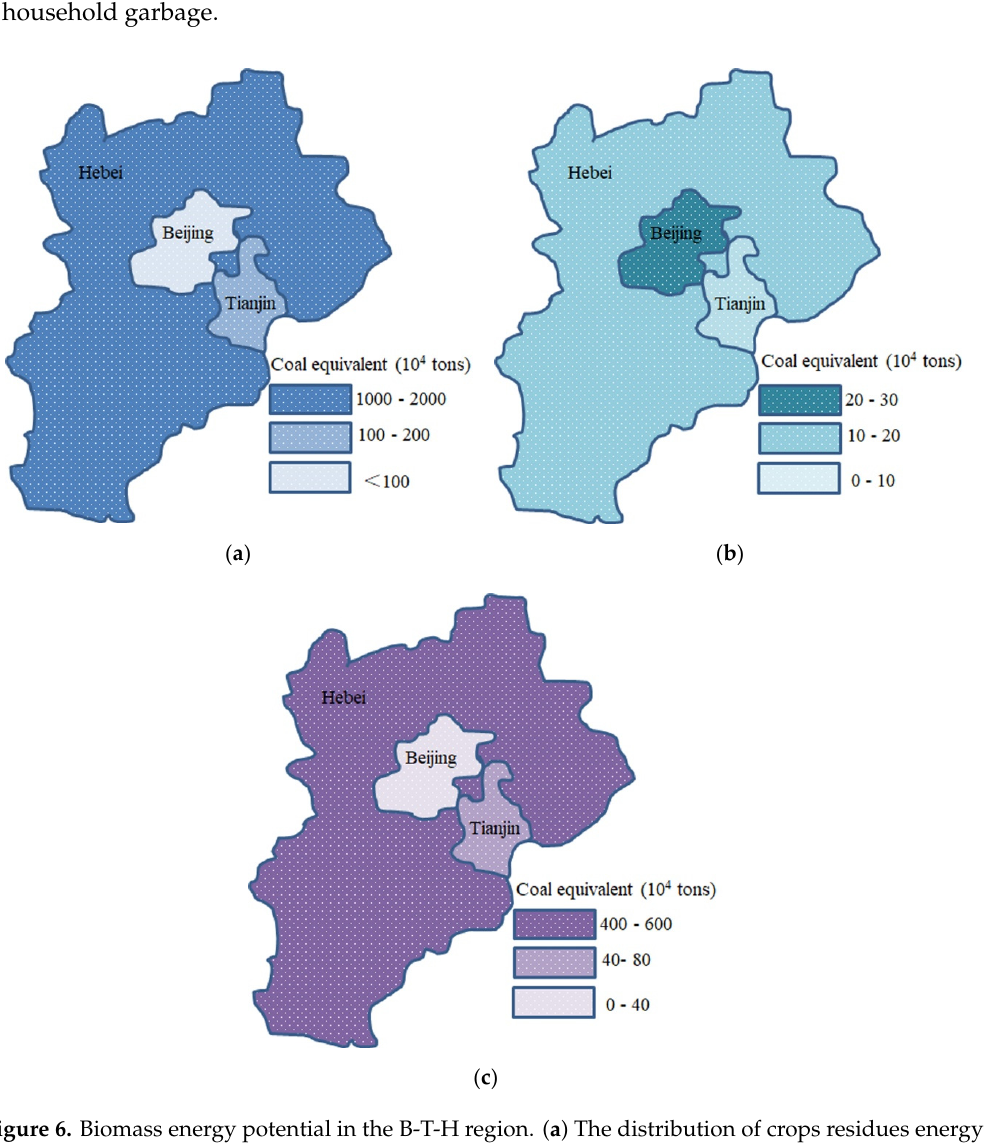
Figure 6. Biomass energy potential in the B-T-H region. ( a ) The distribution of crops residues energy potential in the B-T-H region. ( b ) The distribution of MSW energy potential in the B-T-H region. ( c ) The distribution of human, poultry, and livestock manure energy potential in the B-T-H